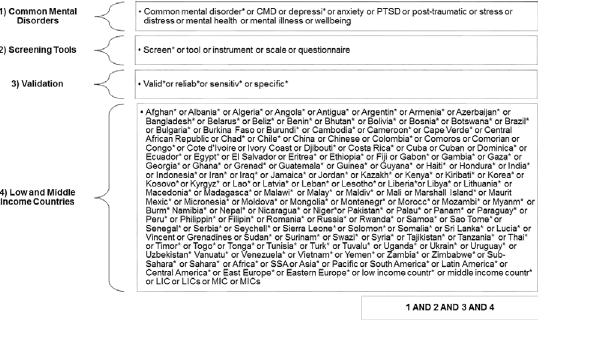
Fig 1. Database search